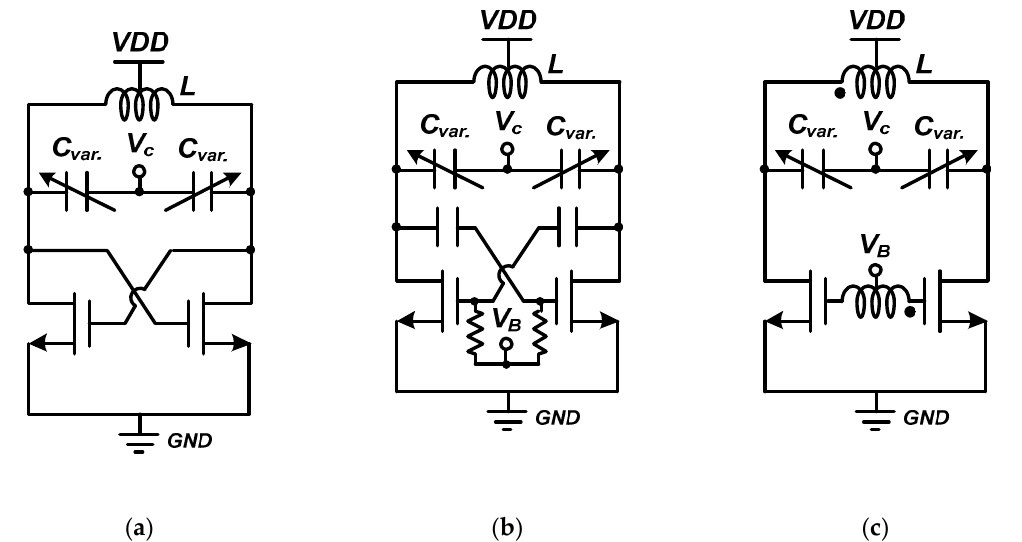
Figure 1. This figure is the circuit diagram of the basic structure for differential LC voltage-controlled oscillator (VCO). ( a ) is a classical class-B VCO and ( b ) is the basic class-C VCO structure and ( c ) is the transformer center-tap biased class-C VCO.